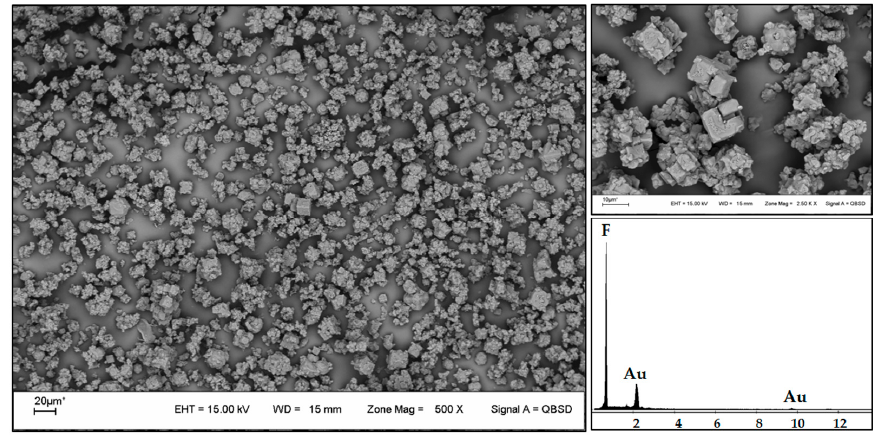
Figure 12. SEM of the precipitated solid by evaporation.